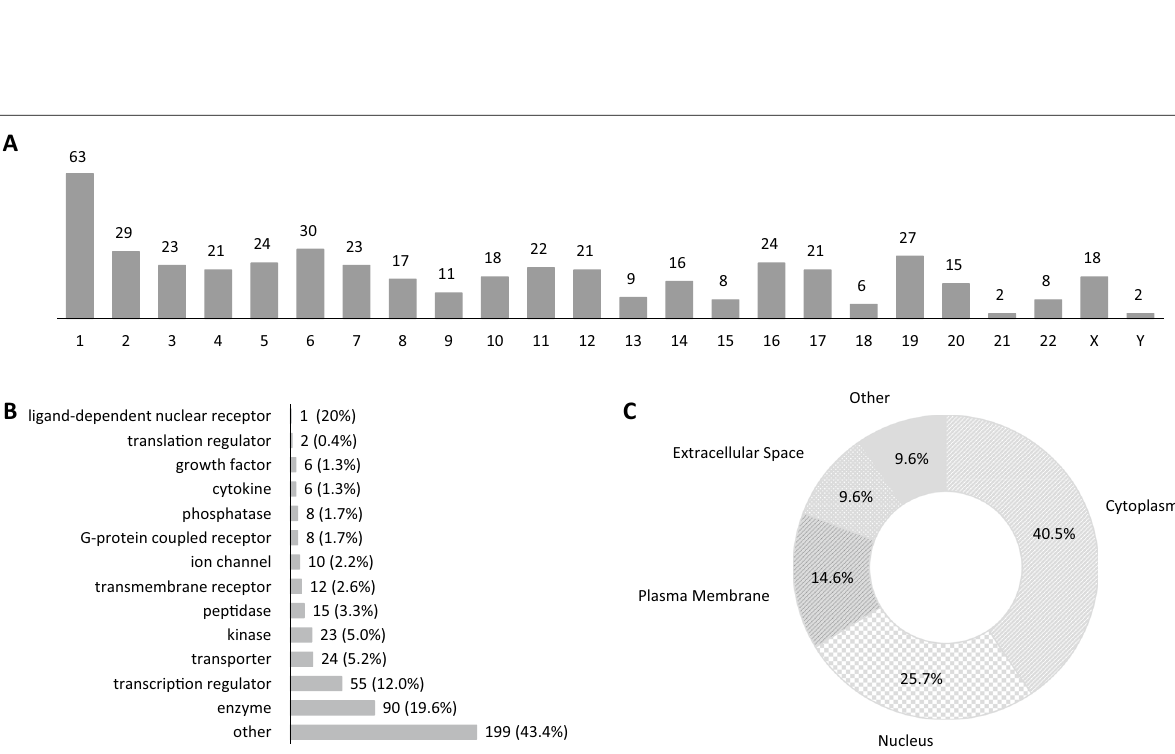
Fig. 2 Distribution of most significantly differentially expressed genes in terms of A chromosomal location, B molecular class, and C cellular